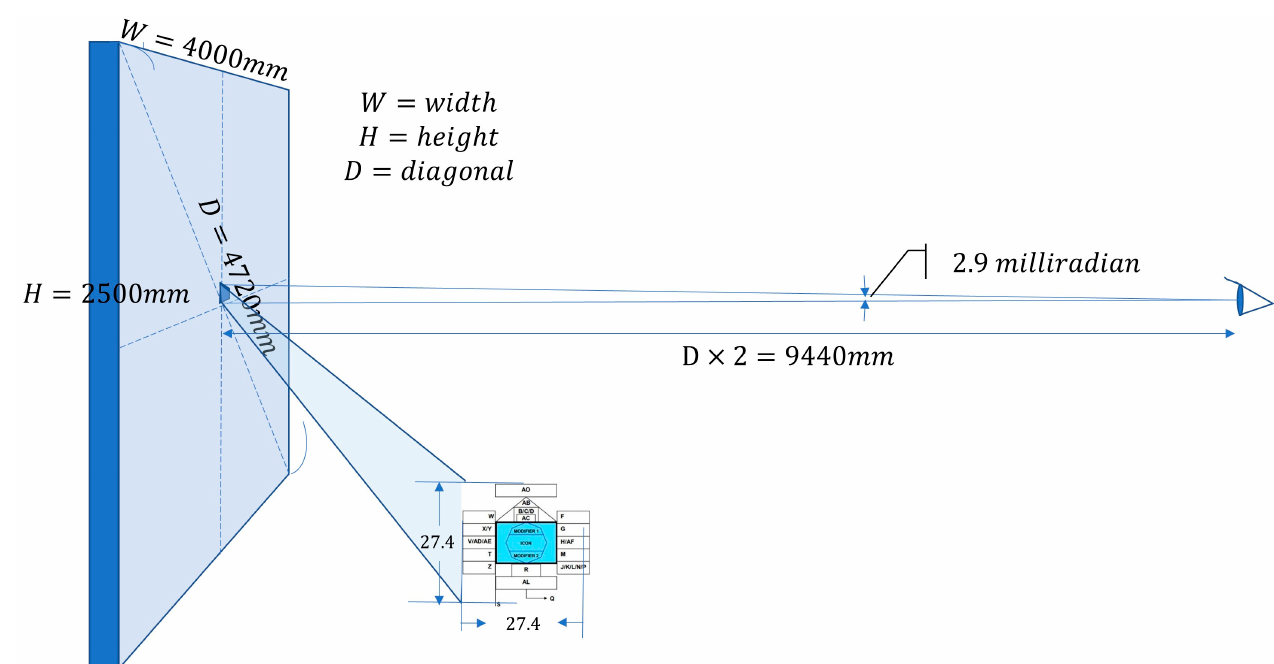
Figure 4. Minimum Viewing Angle according to Line of